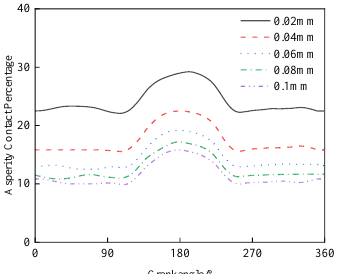
Figure 11. Asperity contact load ratio at different clearances.